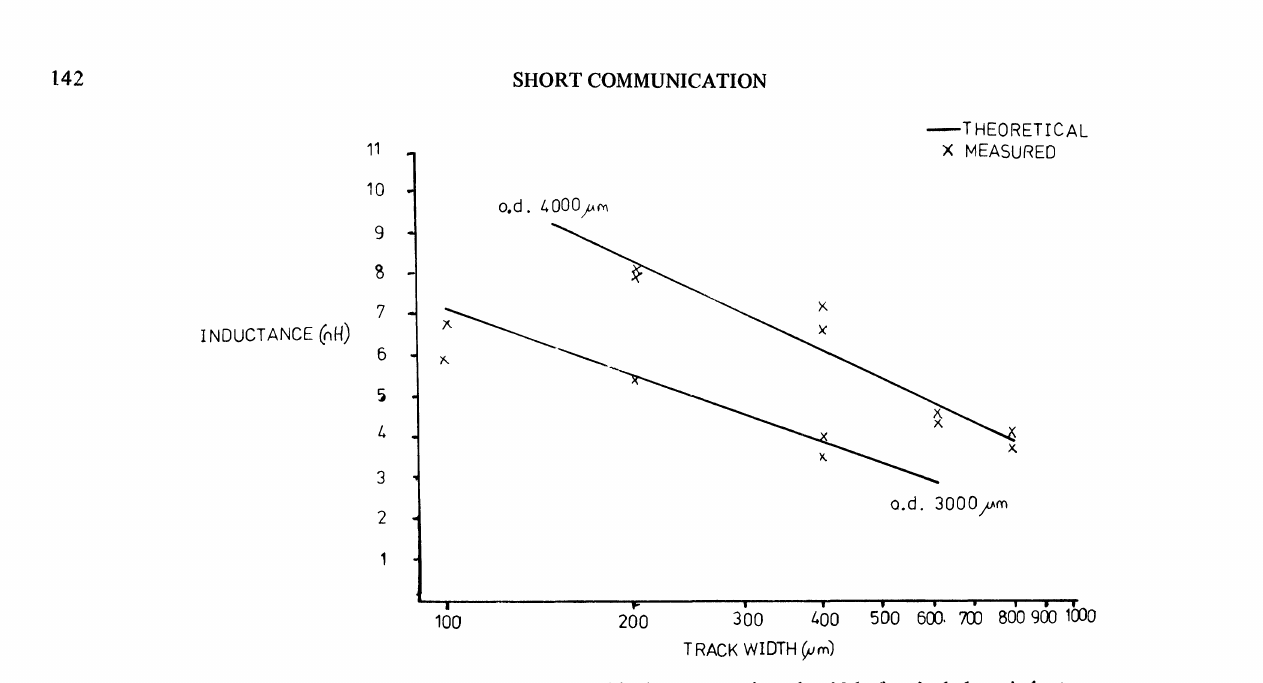
so o, oo 40 do 9o TRACK WIDTH